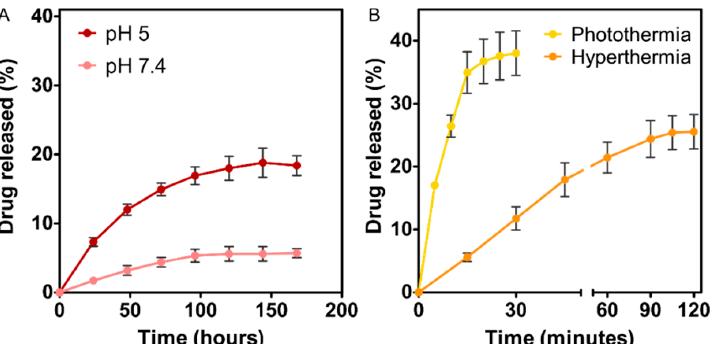
Figure 4. TAT–PLGA(DOXO-BMNPs) as drug nanocarriers. DOXO release at physiological and acidic pH values in ( A ) absence of magnetic hyperthermia and/or photothermia. ( B ) DOXO release at acidic pH in combination with photothermia (2 W/cm 2 ) or magnetic hyperthermia (frequency = 120 kHz, H= 23 kA/m)